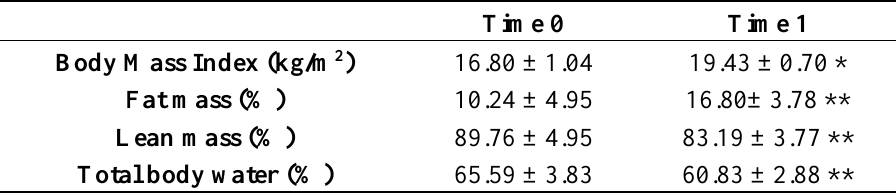
Table 1. Body mass index and body composition (mean and SD) at Time 0 and Time 1.